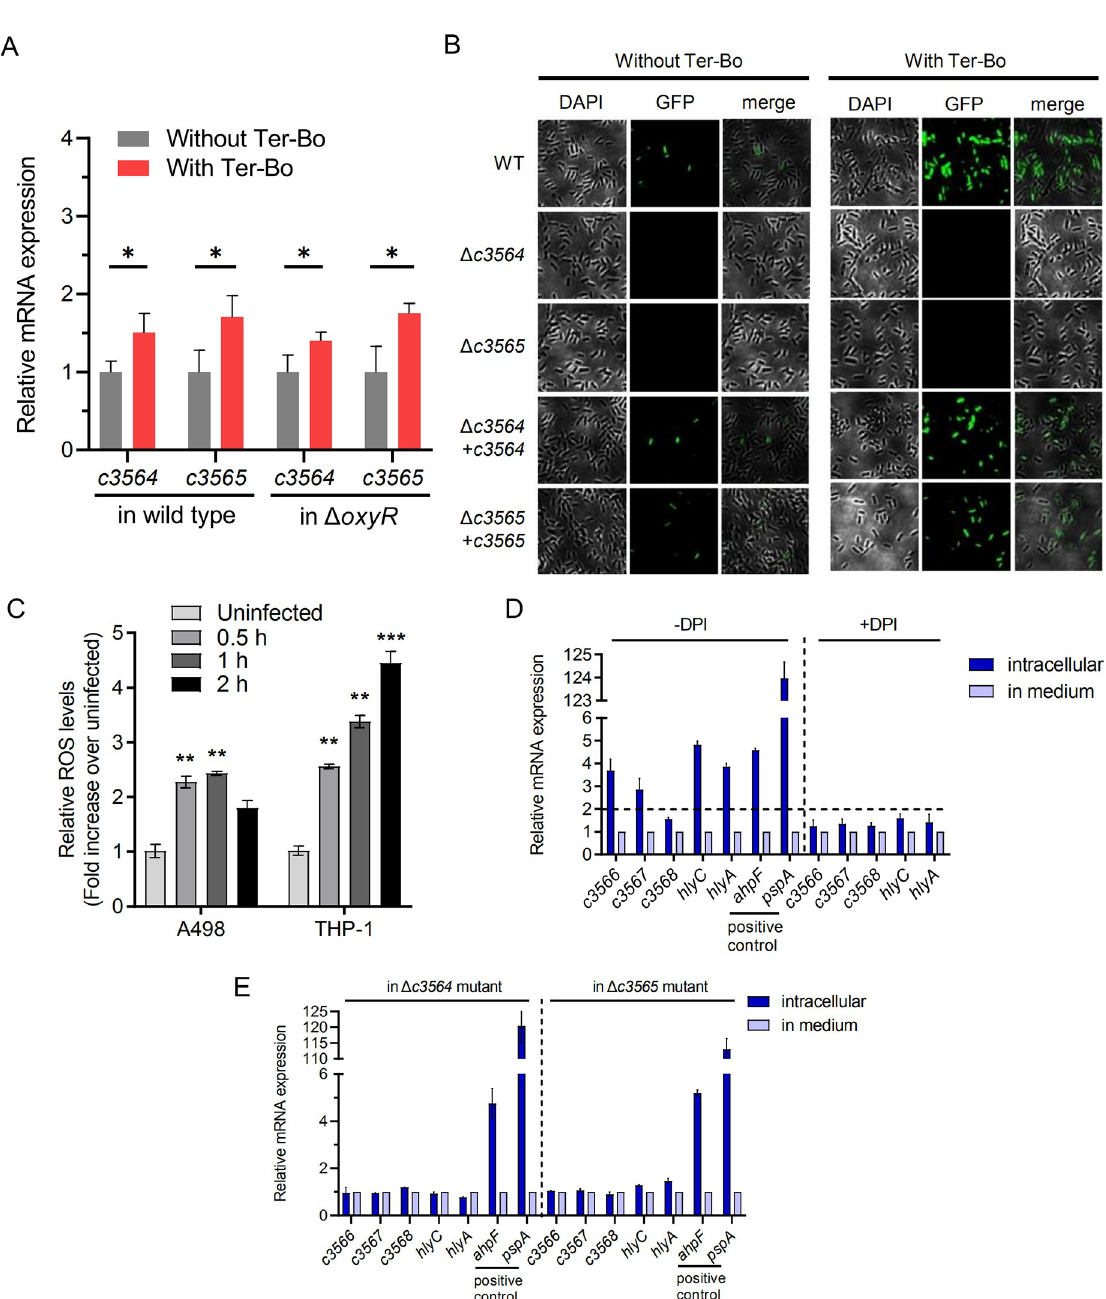
Fig 6. C3564/C3565 activates c3566 - c3568 - hlyCABD expression in response to in vitro and intracellular H 2 O 2 exposure. (A) Stimulation of c3564 and c3565 transcription by H 2 O 2 . Bacteria were treated with 1mM Ter-Bo for 10 mins, followed by RNA extraction and qPCR analysis. Values are the mean ± SD of three replicates from 3 independent experiments. � , P < 0.05 by Student’s t test. (B) Regulation of c3566 - c3568 - hlyCABD expression by C3564/C3565 in response to ROS exposure in vitro . GFP activity was monitored in wild-type CFT073 and its mutants, all of which carried a P -EGFP fusion plasmid. Ter-Bo was added at 1 mM. Representative c3566 fluorescence micrographs are shown. (C) ROS levels in A498 and THP-1 cells upon UPEC infection. Cells were infected with wild-type CFT073 for various amounts of time and then treated with H 2 DCFDA (20 μ M) for 90 min at 37˚C. Cellular fluorescence was assessed using a plate reader (excitation/emission at 485 nm/535 nm), and the levels in the uninfected cells were set to 1. Values represent the mean ± SD of 3 biological replicates from 3 independent experiments. �� , P < 0.01; ��� , P < 0.001 by one-way ANOVA followed by Dunnett’s multiple comparisons test. (D) c3566 - c3568 - hlyCABD expression induction by intracellular ROS. qPCR was used to examine the transcription levels of c3566 - c3568 - hlyCABD , and the gene transcription levels in bacteria grown in medium were set as 1. To inhibit the production of ROS, DPI, an inhibitor of NADPH oxidase, was added at 100 μ g/mL. The dashed lines represent a fold change cutoff of 2, and a fold change �